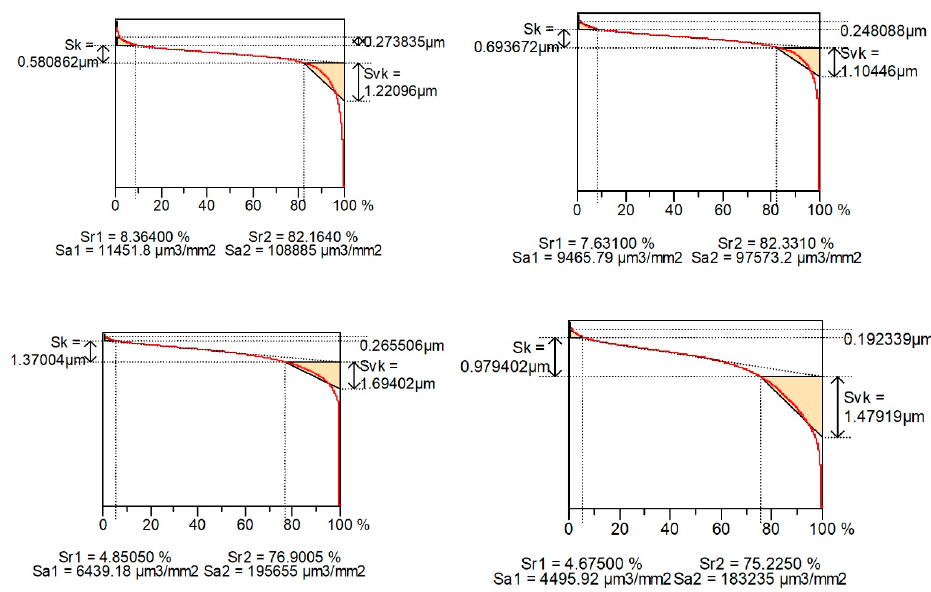
Figure 5. Material ratio curves of surfaces shown in Figure 4. Table 1 lists the coefficients of linear correlation between the selected parameters of the plateau ‐ honed cylinder surfaces. Table 1. Coefficients of linear correlation between the selected parameters of the plateau ‐ honed cylinder surfaces, the strong correlations are marked by yellow color.